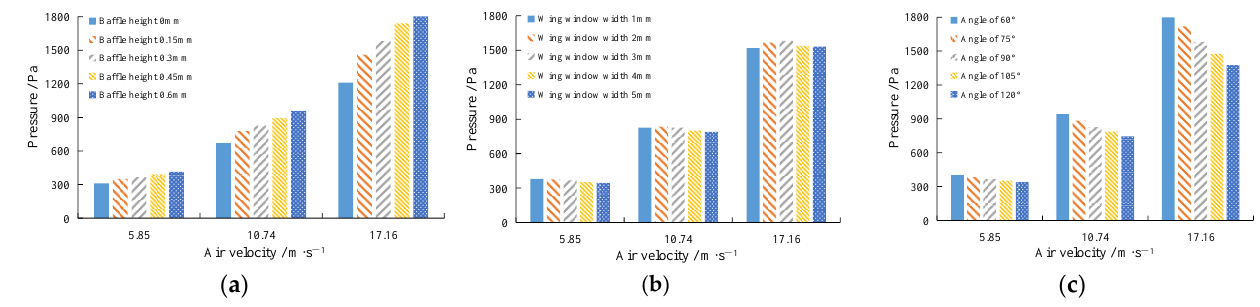
Figure 11. The influence of three factors on the pressure; ( a ) baffle factor; ( b ) wing window factor; ( c ) angle factor.